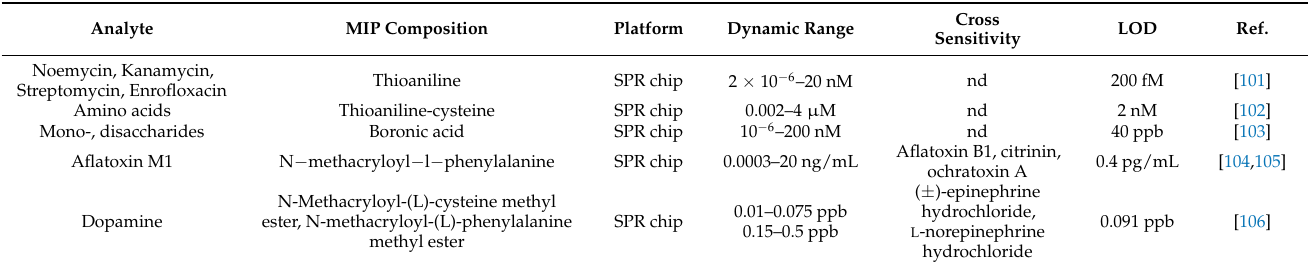
Table 4. Summary of the AuNPs-decorated MIP–based SPR sensors described in Section 2.3.